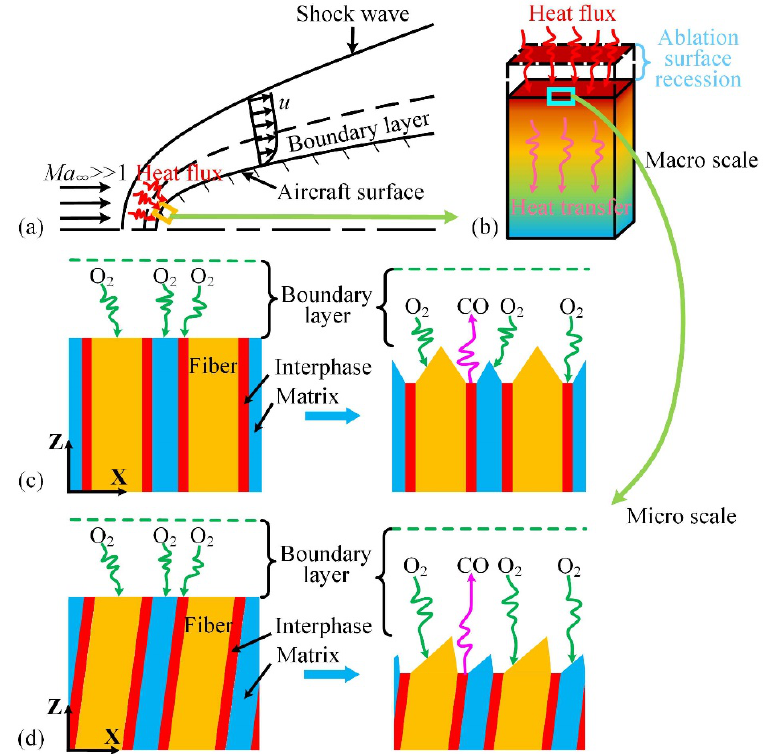
Figure 1. Schematic diagrams of ( a ) hypersonic flow around a bluff body; ( b ) heat transfer and ablation surface recession at the macro scale; ( c ) changes in the surface morphology of vertical fibers before and after ablation at the micro scale; and ( d ) changes in the surface morphology of inclined fibers before and after ablation at the micro scale.